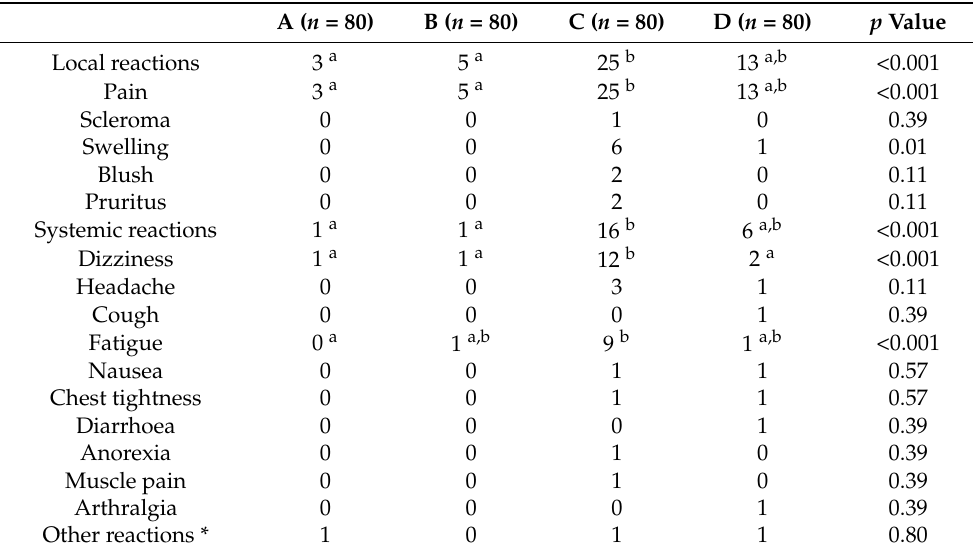
Table 5. Specific reactions across the four groups.